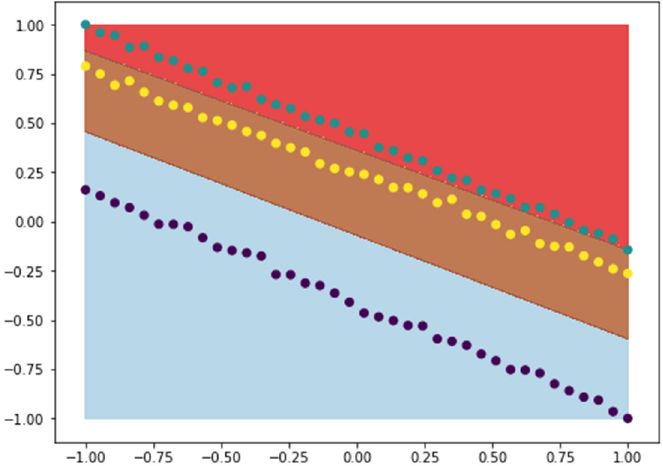
Figure 18. Data set and regions defined by the SVM classifier.